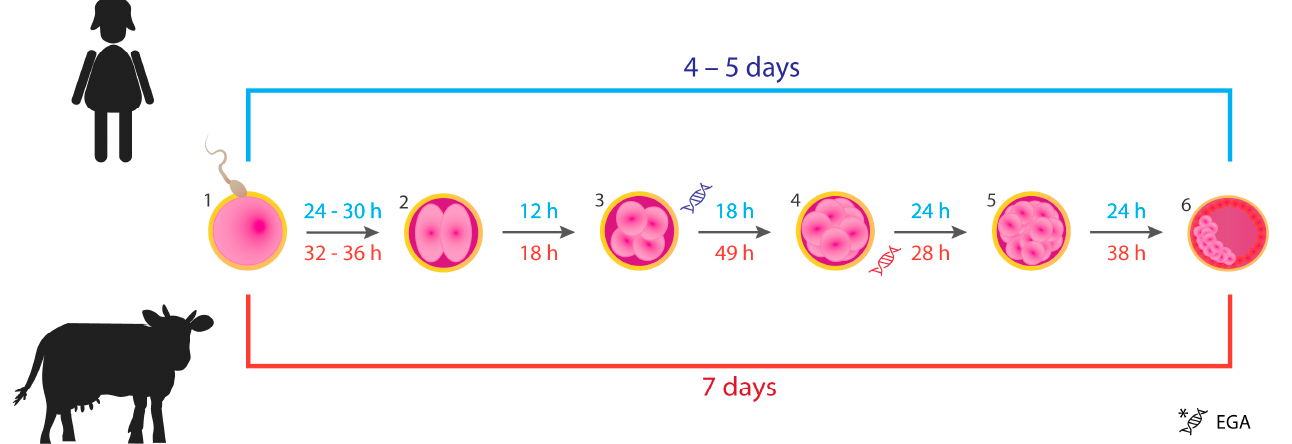
Figure 1. Timing of the early development of human (blue color) and bovine (red color) embryos from fertilization to the blastocyst stage. (1) Spermatozoon penetrates the zona pellucida of the oocyte: fertilization. (2) Zygote after the 1st cell division (2-cell). (3) Embryo after the 2nd cell cycle (4-cell). (4) Embryo after the 3rd cell cycle (8-cell). (5) Morula, embryo at 16- to 32-cell stage. (6) An early blastocyst: the inner cell mass (embryo proper) represented by the pink clustered cells will di ff erentiate into structures that will give rise to a fetus. Trophoblasts surrounding the blastocyst cavity (depicted as red cells) will develop into the placenta. Stages at which embryonic genome activation (EGA) occurs in both species are shown. The fi gure was based on the information provided in articles [27–29,31–33].